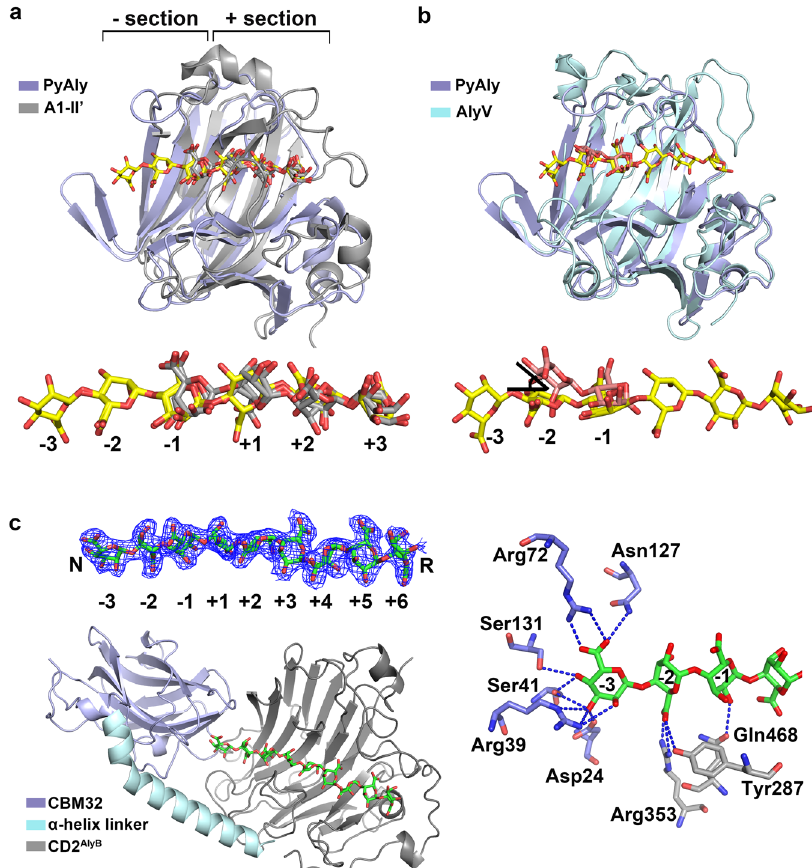
Fig. 4 Comparative analysis of the substrate binding pro fi les of PyAly, A1-II ’ , AlyV and AlyB revealed the relationship between the “ - ” section and product distribution. a Structural comparison of the PyAly H125A -M8 + M5 complex and the A1-II ’ -GGMG complex. The sugars bound in PyAly and A1-II ’ are shown as sticks in yellow and gray, respectively. The substrate binding clefts of PL7 alginate lyases were divided into “ + ” sections and “ - ” sections using the cleavage site as the boundary. Similar substrate binding pro fi les at the “ + ” sections were observed. b Structural comparison of the PyAly H125A -M8 + M5 and AlyV R91A -M8 complexes. The sugar bound in AlyV is shown in salmon. A clear angle was observed between the two sugar units at subsites -2, indicating different substrate binding pro fi les in the “ - ” sections. c Structural analysis of the AlyB H360A_Y466A -G9 complex. AlyB is shown in cartoon, and G9 is shown in green. The electron density map for G9 (contour level 1 σ ) is presented. The residues that formed hydrogen bonding interactions with subsites -3 to -1 are shown as sticks: the residues from CBM32 are in slate, and the residues from CD2 AlyB are in gray. Hydrogen bonds are indicated with blue dashed